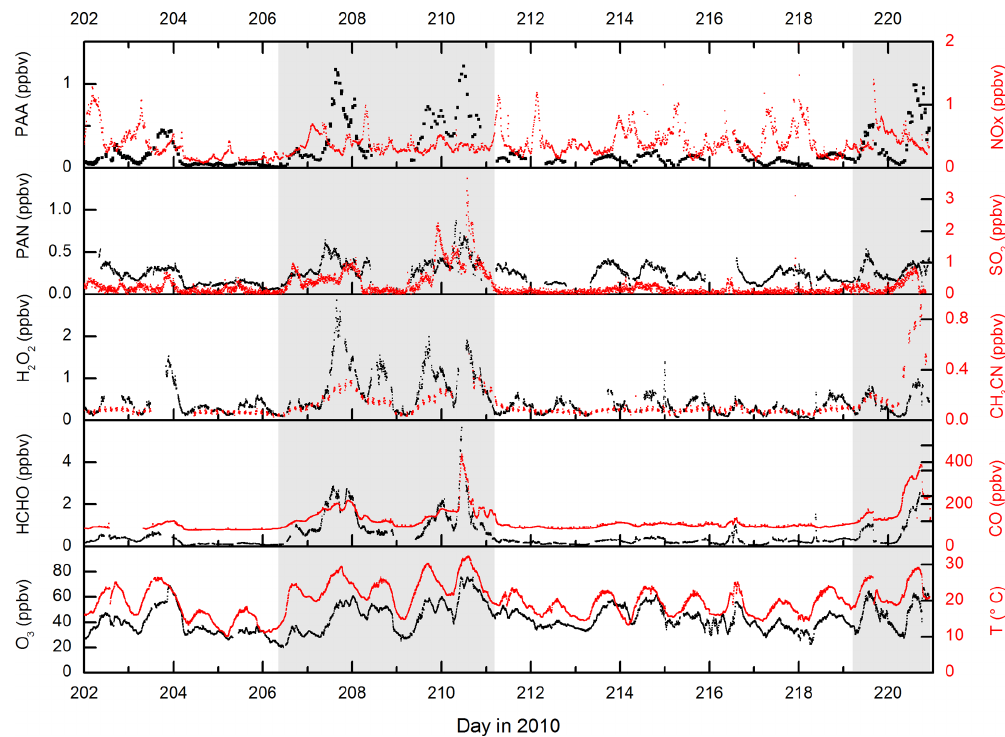
Figure 1. Measurements of PAA (CH 3 C(O)OOH), PAN (CH 3 C(O)O 2 NO 2 ) and other trace gases during HUMPPA-COPEC-2010. Day 202 was the 20 July 2010. The shaded areas represent two periods in which the site was impacted by biomass-burning plumes originating from